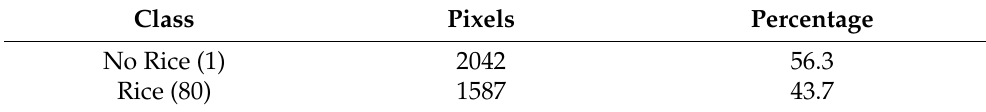
Table 3. Learning matrix layout.